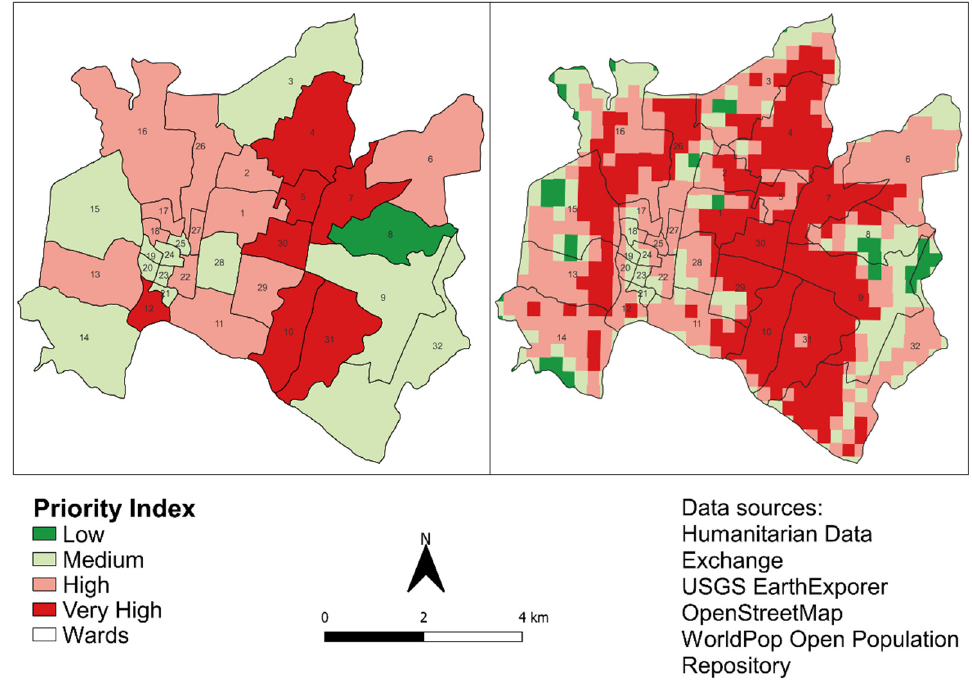
Figure 6. The Priority Index for UGS establishment — aggregated at the ward level ( left ) and the fishnet level ( right ).